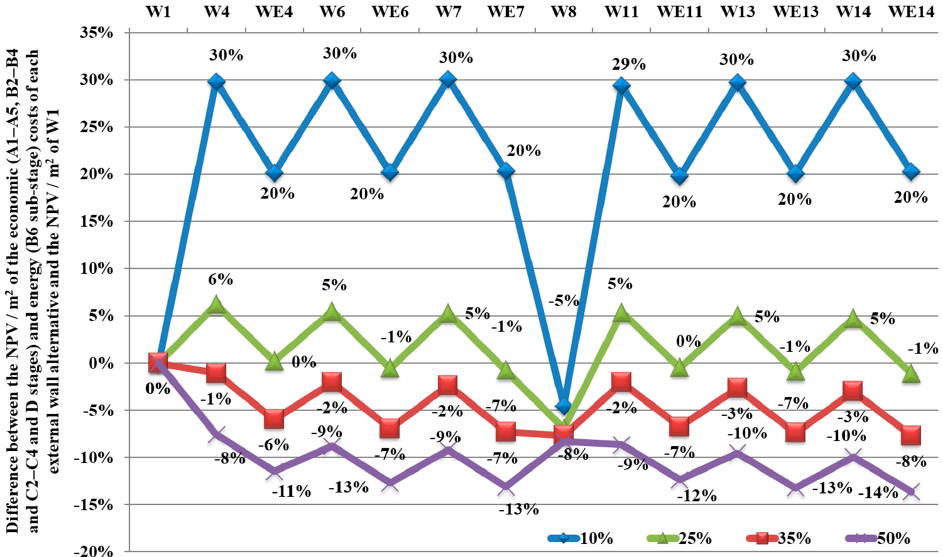
Figure 9. NPV/m 2 of external wall of the economic (A1–A5, B2–B4 and C2–C4 and D stages) and energy (B6 stage) costs of ETICS with ICB and EPS.